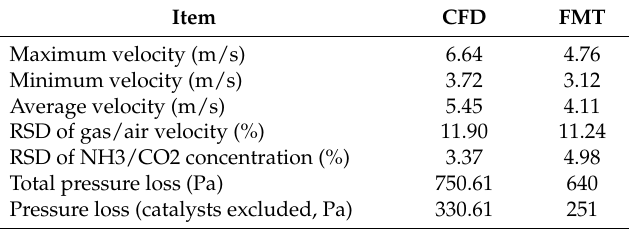
Table 4. Comparisons between computational fluid dynamics (CFD) simulations and FMT